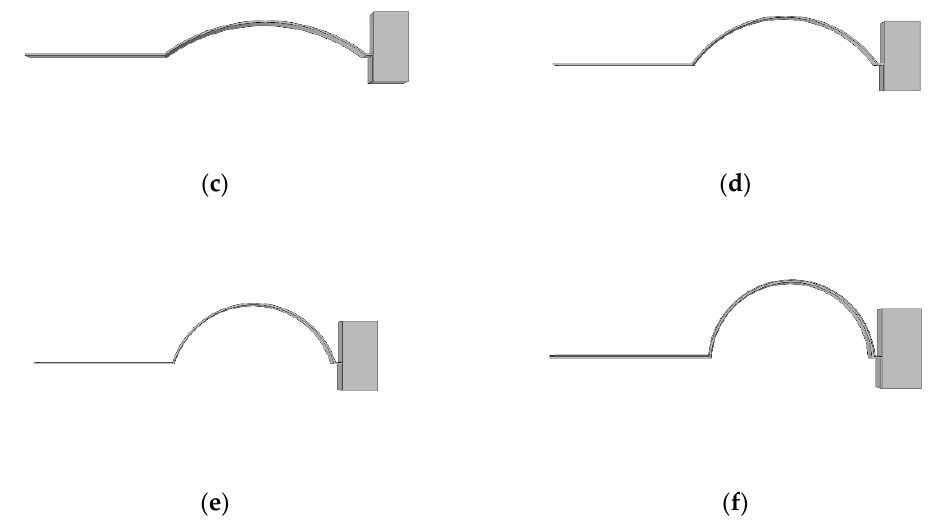
Figure 2. Three-dimensional schematic: ( a ) curvature is 0 m − 1 ; ( b ) curvature is 20 m − 1 ; ( c ) curvature is 40 m − 1 ; ( d ) curvature is 60 m − 1 ; ( e ) curvature is 80 m − 1 ; ( f ) curvature is 100 m − 1 .